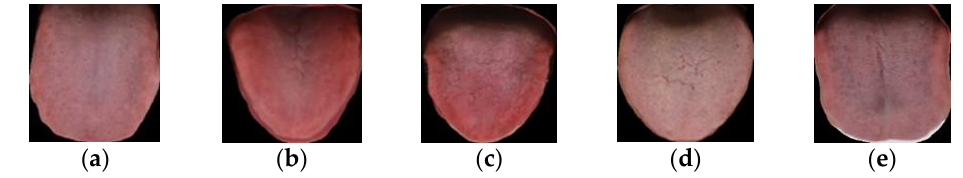
Figure 2. Samples of five types of tongue images. ( a ) Light red tongue; ( b ) Red tongue; ( c ) Deep red tongue; ( d ) Light white tongue; ( e ) Cyan tongue.